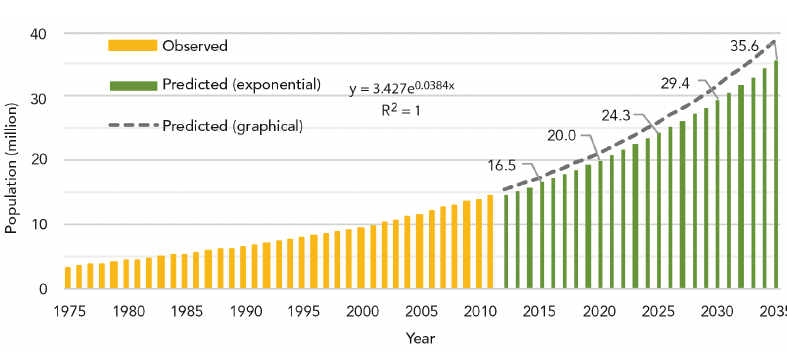
Figure 3: Observed and forecasted population of the study